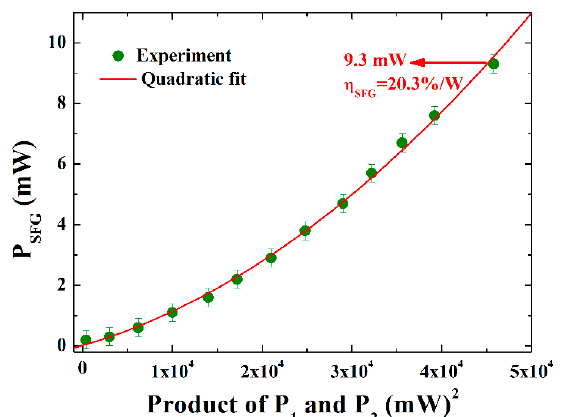
Figure 4. Measured SFG output power (green circles) as a function of the product of input fundamental power at ∆ T = 0 ◦ C. The solid red curve is a quadratic fit to the SFG data using P SFG = η SFG P 1 P 2 , where η SFG = 20.3%/W is the SFG normalized conversion efficiency determined from power measurements. The error bars include the uncertainty in the output power measurements.